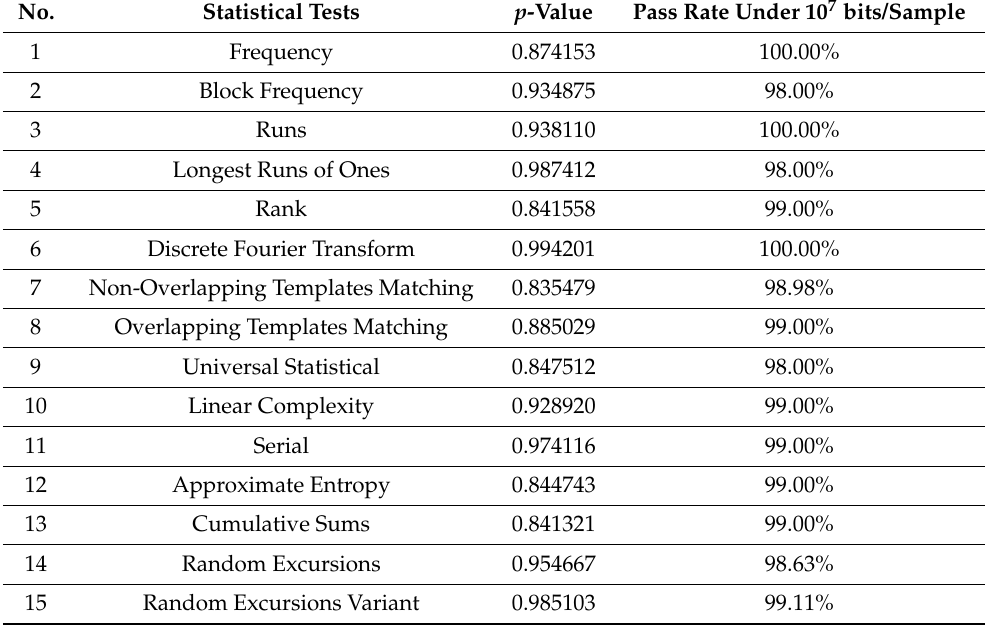
Table 11. Statistical Test under NIST